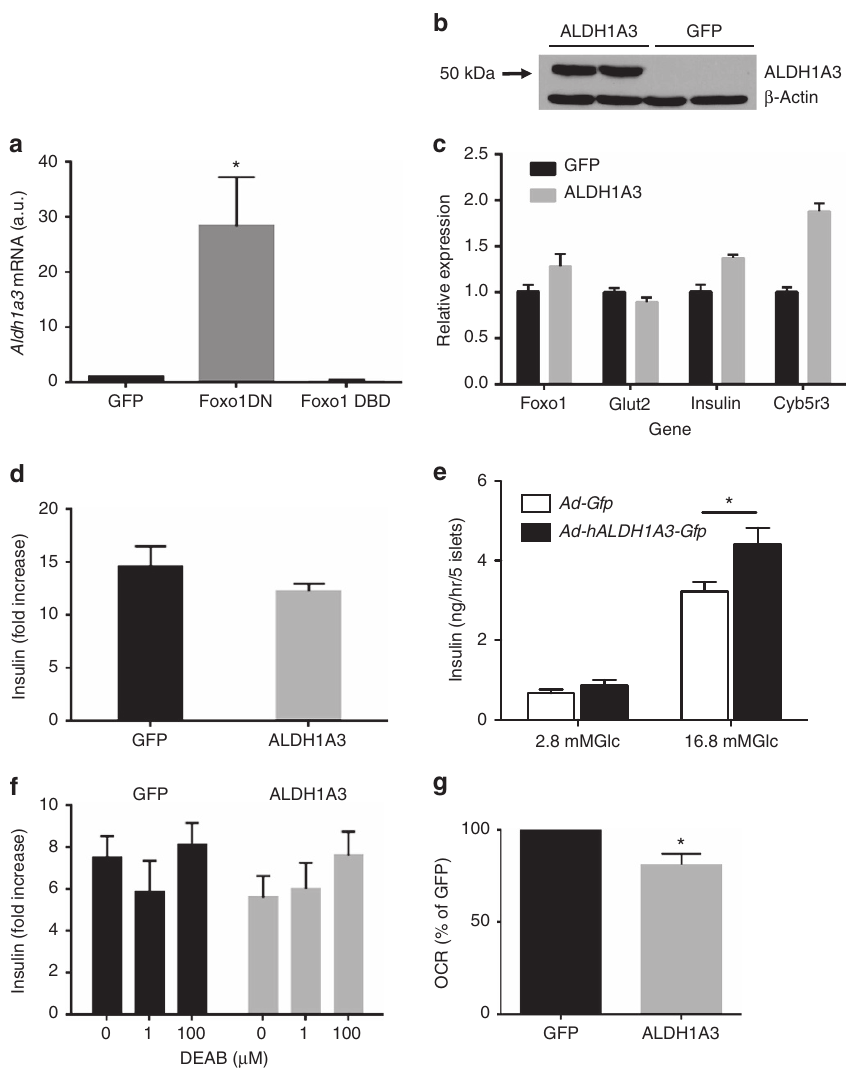
Figure 3 | ALDH gain-of-function in b cells. ( a ) Effect of Foxo1 overexpression on Aldh1a3 mRNA in Min6 cells. Foxo-DN is a truncated mutant that is unable to drive gene expression and competes with endogenous Foxo for DNA binding. Foxo- DNA-binding deficient (DBD) is a mutant unable to bind the Foxo response element, but can still function as a coregulator of gene expression 28 . ( b ) Western blot analysis of ALDH1A3 levels following lentiviral transduction in MIN6 cells. ( c ) Gene expression in Min6 cells stably expressing GFP or ALDH1a3. ( d ) Insulin secretion expressed as fold-increase from 5 to 20mM glucose in MIN6 cells expressing either GFP or ALDH1A3 ( n ¼ 8). ( e ) Insulin secretion in MIN6 cells stably transfected with ALDH1A3 ( n ¼ 3). ( f ) Insulin secretion (expressed as in panel d ) in islets isolated from db/db mice and their wild-type controls following treatment with the ALDH inhibitor N,N-diethylaminobenzaldehyde (DEAB) at the doses indicated ( n ¼ 4). Each experiment was performed with pooled islets from 5 mice per genotype. ( g ) Area under the curve of oxygen consumption rates measured in Min6 cells stably expressing either GFP or ALDH1A3 ( n ¼ 4 per group). One asterisk indicates P o 0.05 by one-way ANOVA. Error bars indicate